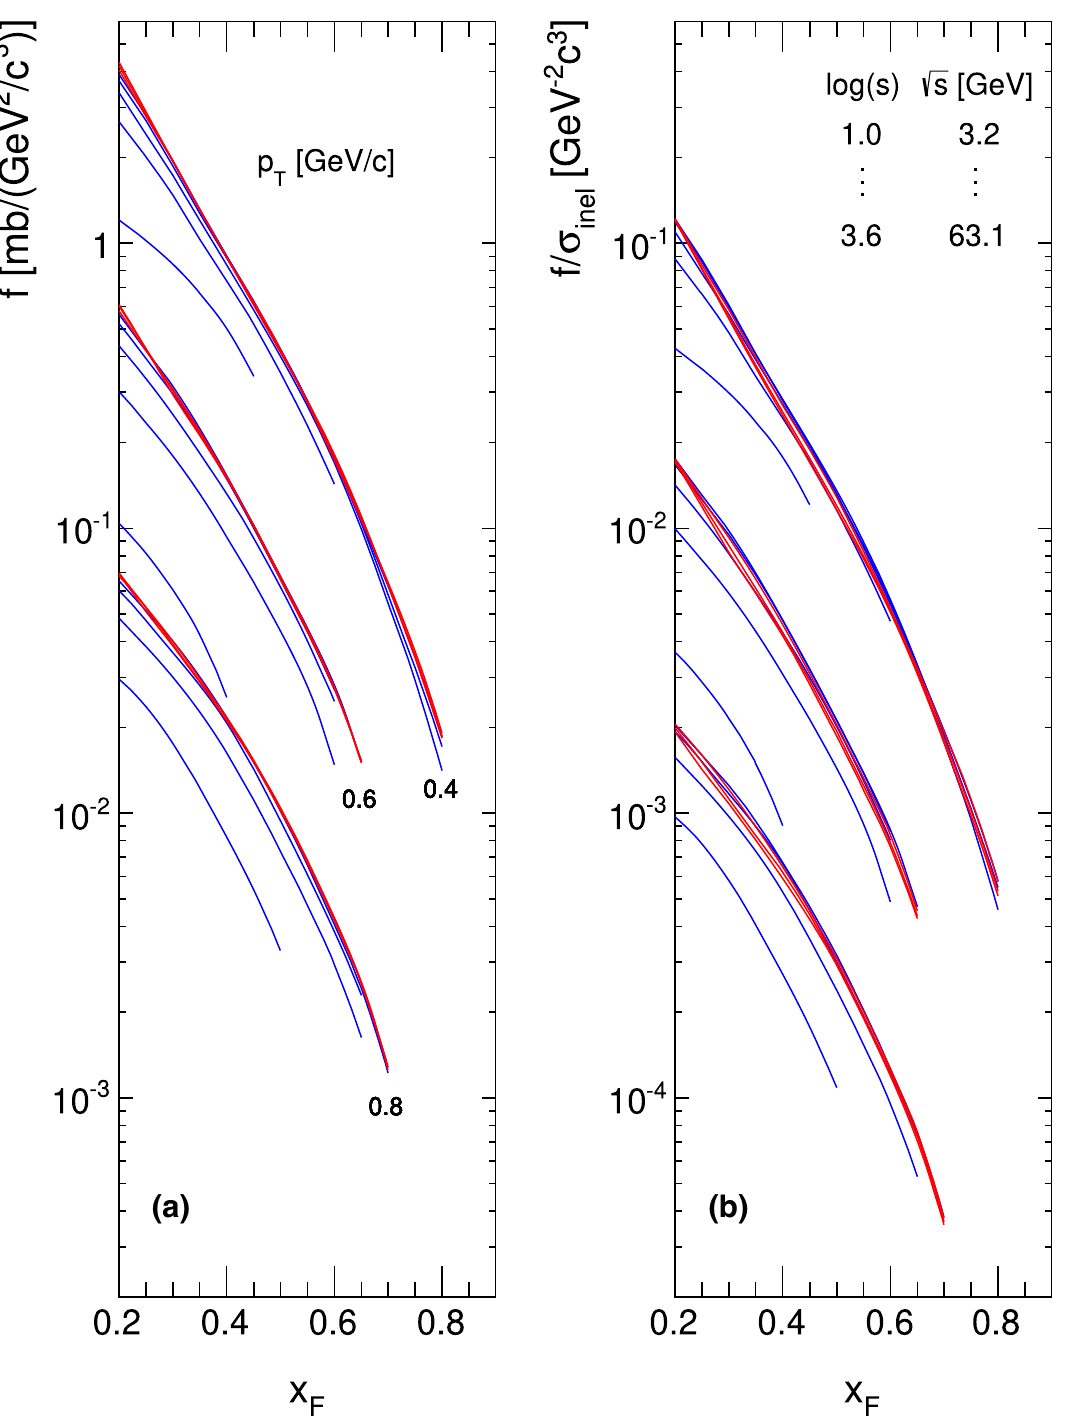
Fig. 113 a f ( x F , p T ) as a function of x F for p T = 0.4, 0.6 and 0.8 GeV/c for the global interpolation at log ( s ) values from 1.0 to 3.6. The lines at subsequent p T values are scaled down by 1/3 for better separation. b f ( x F , p T )/σ